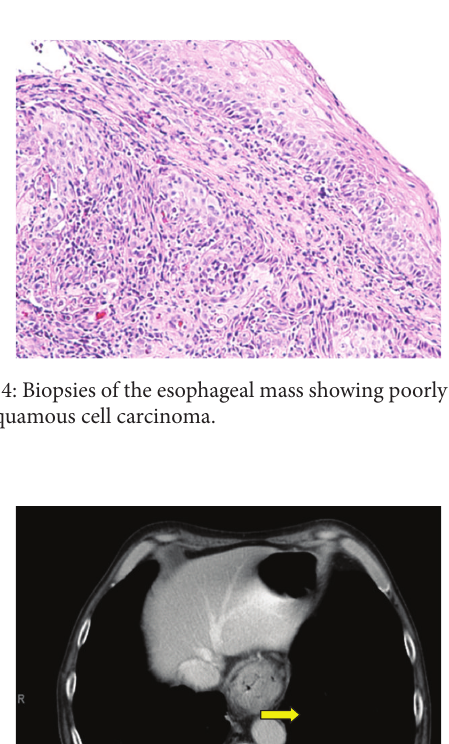
Figure 3: A non-circumferential, partially obstructing mass seen in the lower third of the esophagus.